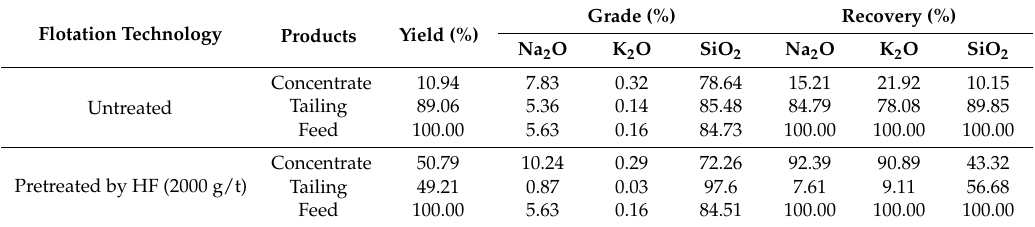
Table 3. Flotation results of artificial mixture of feldspar and quartz using DDA as